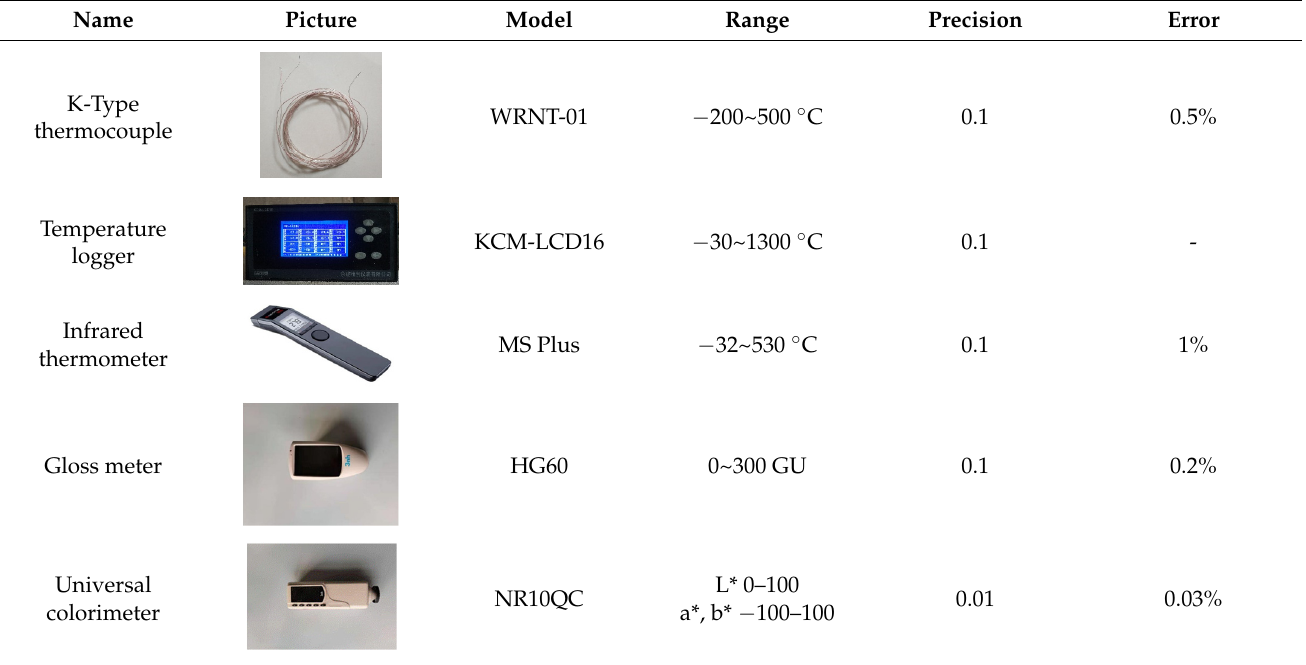
Figure 3. Catalytic infrared radiation panel. Table 1. Details of the experimental instruments.